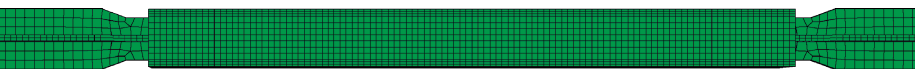
Figure 16: Finite element model in software ABAQUS.